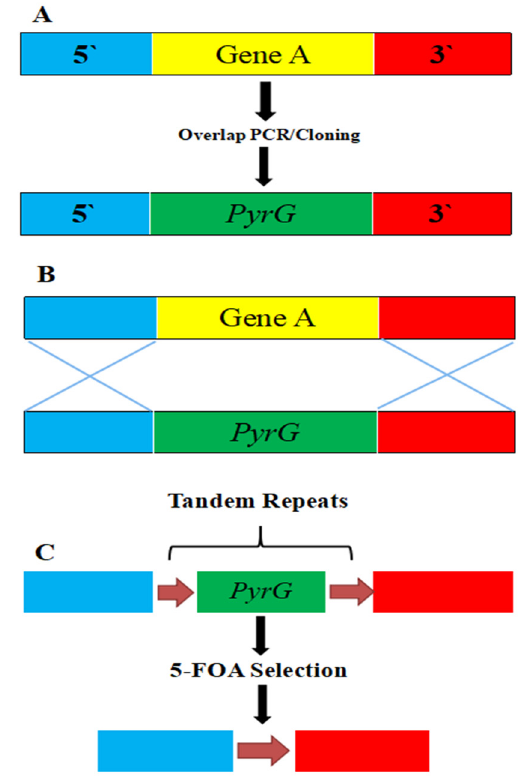
Figure 1. Representation of gene deletion in Mucor and Rhizopus spp. ( A ) ~1 kb of the 5 (cid:48) and 3 (cid:48) end of the target gene is incorporated on their respective sides to the pyrG marker gene. This is accomplished via overlapping PCR or cloning methods. ( B ) The deletion construct is delivered into the fungal cells via protoplastic transformation, electroporation, or biolistic transformation for homologous gene replacement. ( C ). To construct a recyclable marker, the pyrG gene is flanked on either side with a 237-bp repeat, resulting in the pyrG-dpl237 marker. The tandem repeats of 237 bp around the pyrG gene facilitate the excision of the pyrG marker after target gene deletion